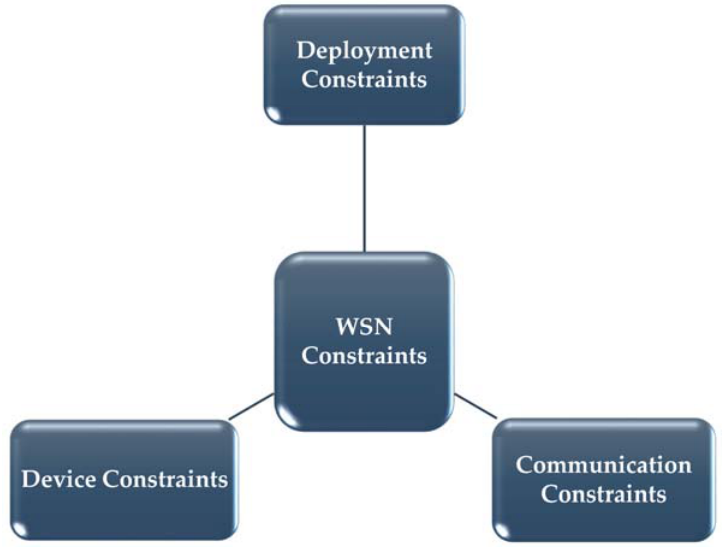
Figure 3. Major WSN